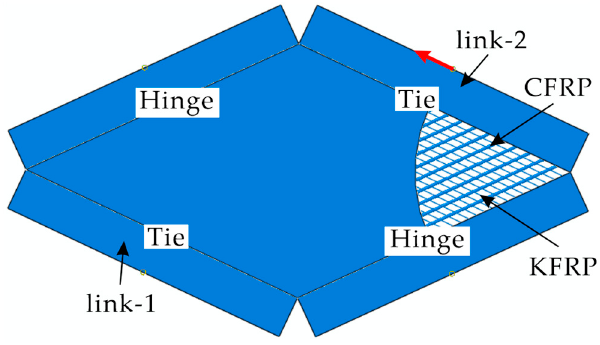
Figure 5. Finite element model of the skin module.